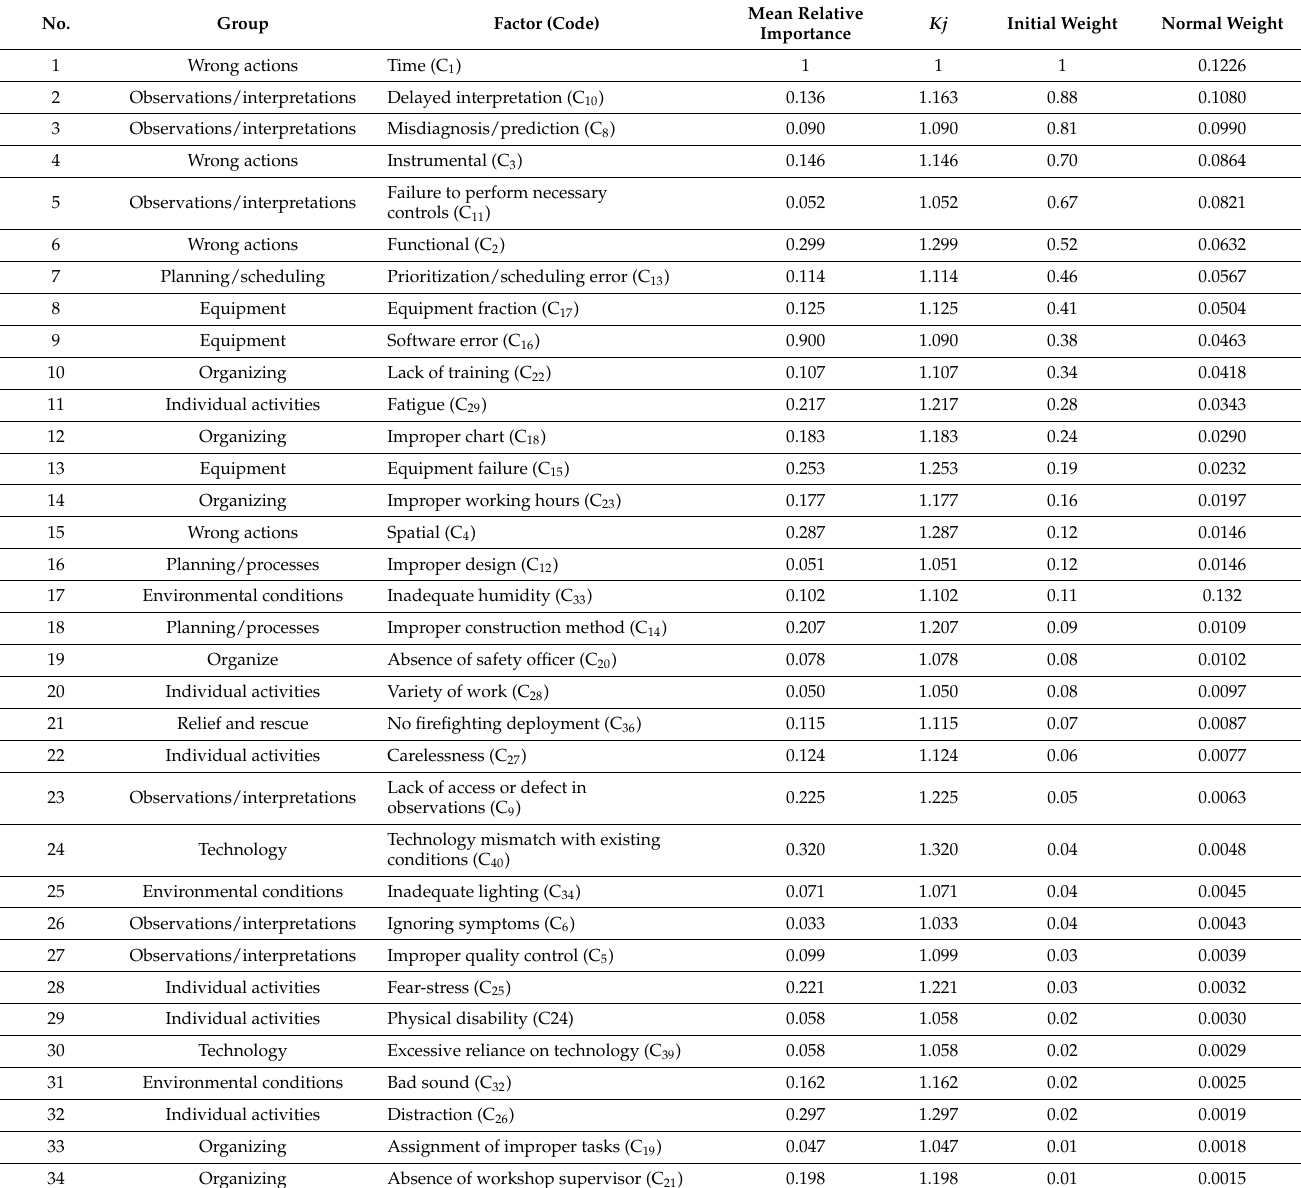
Table 3. Prioritization of human error indices by the SWARA